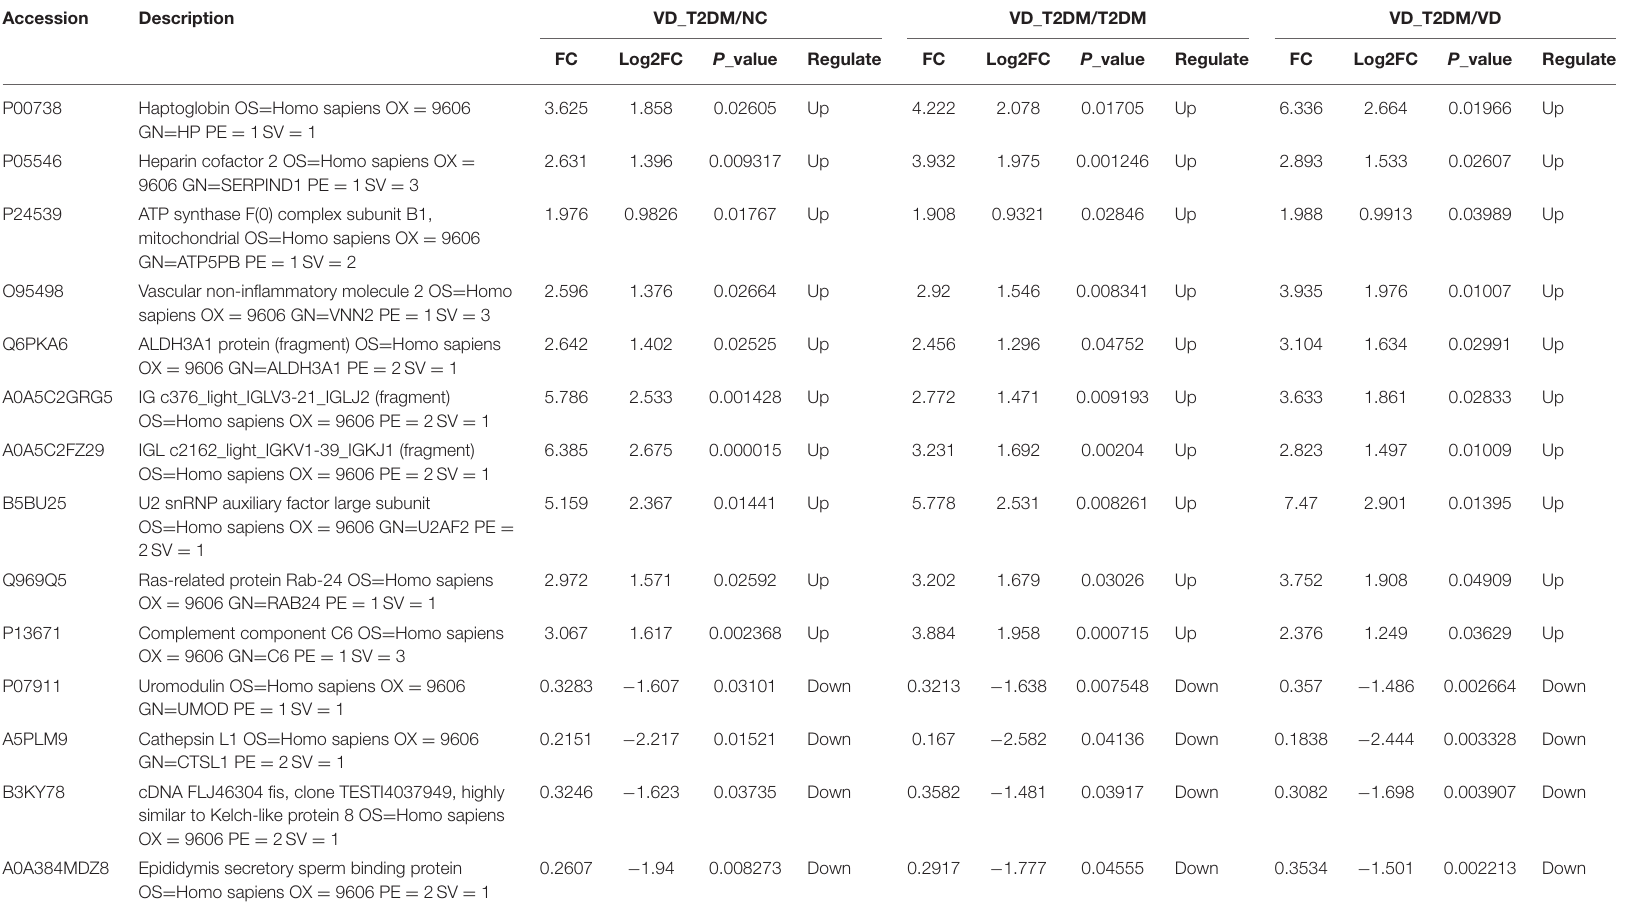
TABLE 2 | Urinary DEPs between patients with VD + DM, patients with VD, patients with DM, and NCs. Accession Description